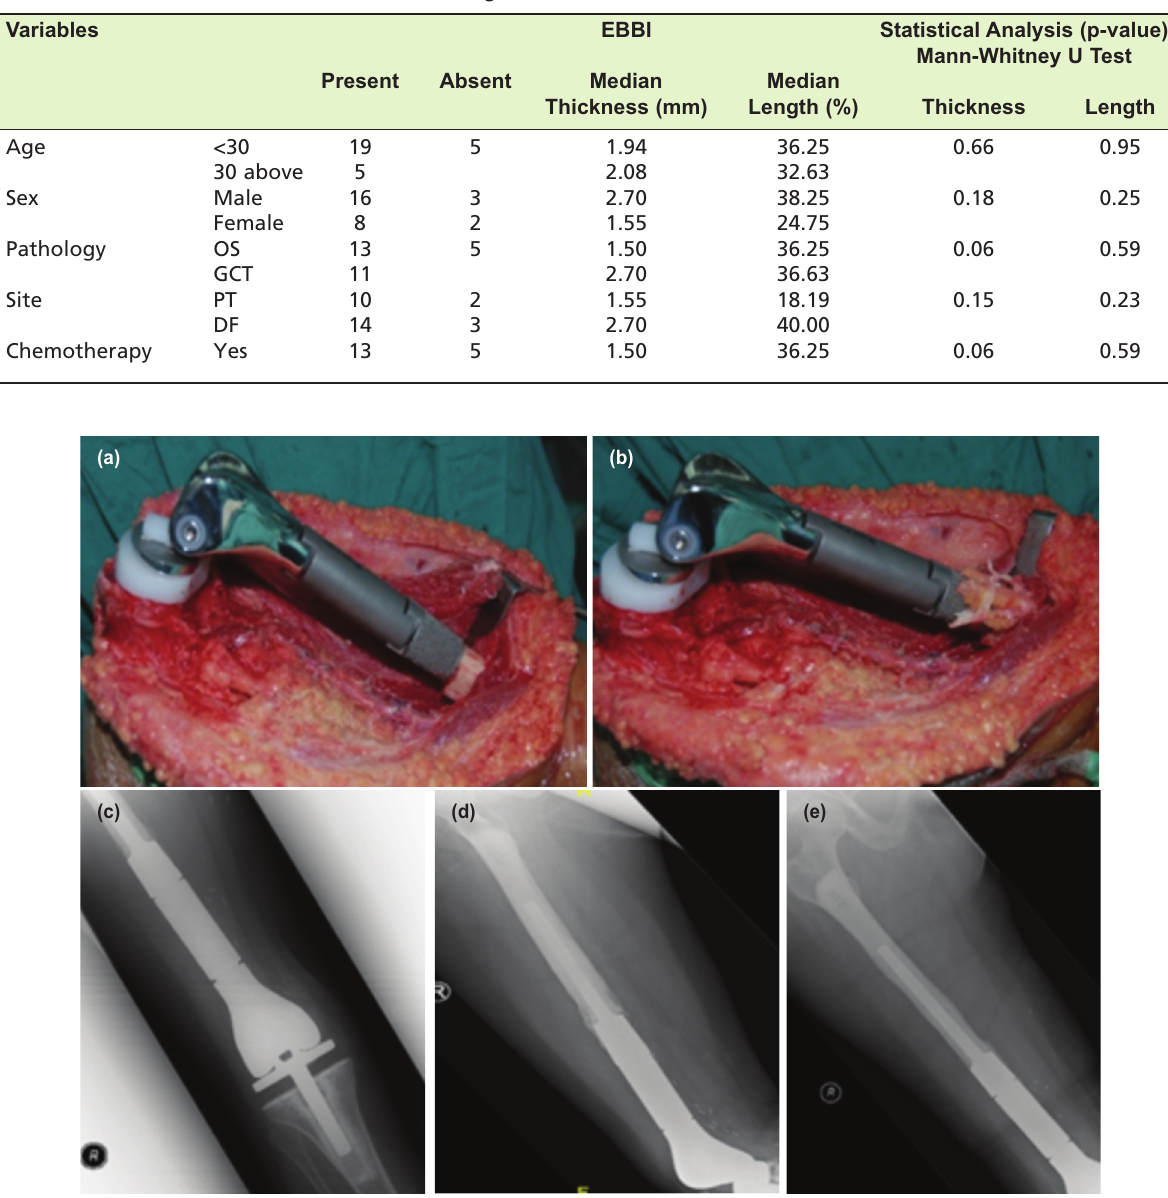
A case of distal femur endoprosthesis; minimal formation of EBBI around prosthesis junction and showed stem loosening at 15 Fig. 1: years after surgery (not in the study as none of cases in this study had early loosening. (a) A case of distal femur osteosarcoma; wide resection reconstructed with endoprosthesis. (b) Multiple bone sleeve at bone-implant junction for formation of EBBI. (c) Antero-posterior radiograph of knee with distal femur endoprosthesis. (d) Lateral radiograph of knee with distal femur endoprosthesis (at 15 years). (e) Antero-posteior radiograph of knee with distal femur endoprosthesis (at 15